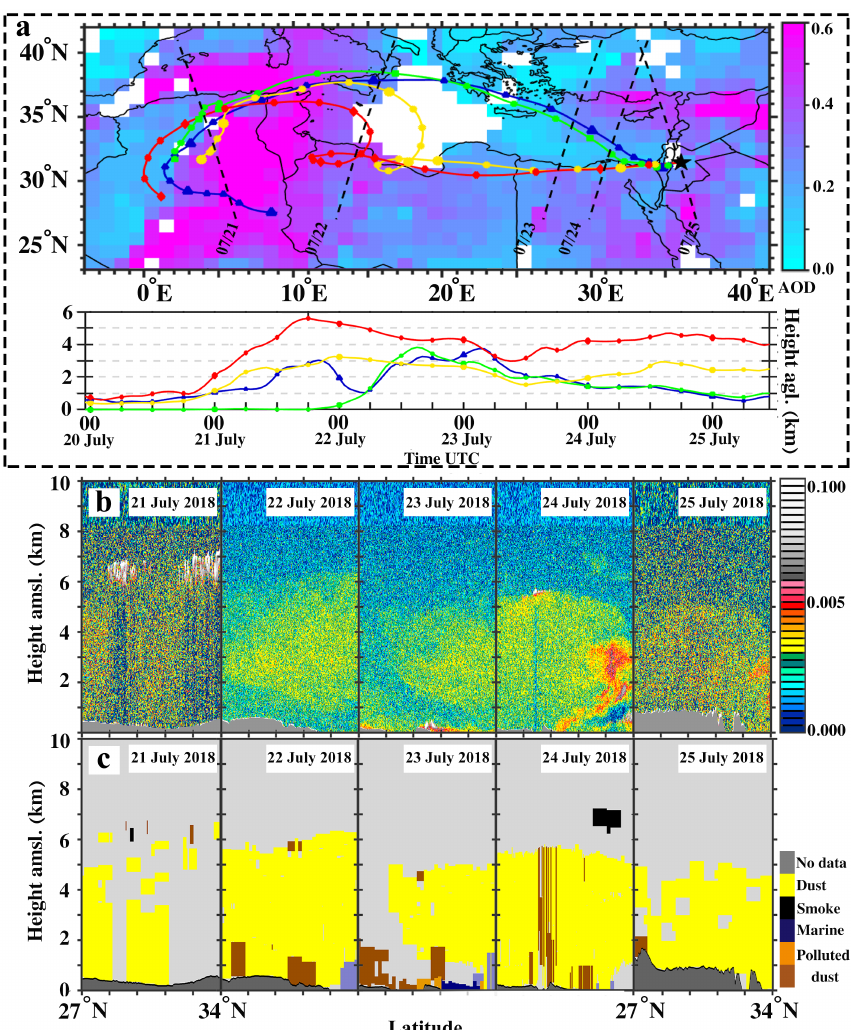
Figure 8. ( a ) Backward trajectories during the past 132 h by the HYSPLIT model on 25 July 2018 cal- culated at different heights, overlaid by MODIS Deep Blue AOD (on 21 July 2018) and corresponding CALIPSO ground track during transport path. ( b ) The attenuated backscatter coefficient in arbitrary units (AU). ( c ) The CALIPSO aerosol subtype classification. The horizontal axis for all panels of Figure 8b,c is the same. This axis shows latitude from 27 ◦ N to 34 ◦